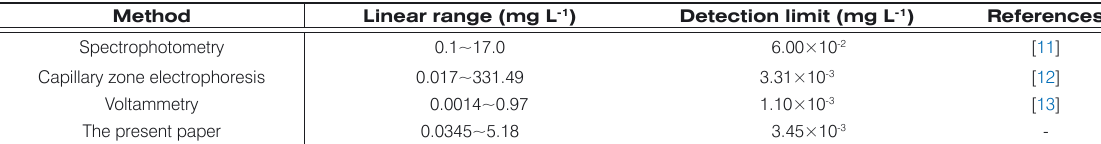
Table 2. Compared the proposed method with others used for determining p- nitroaniline.